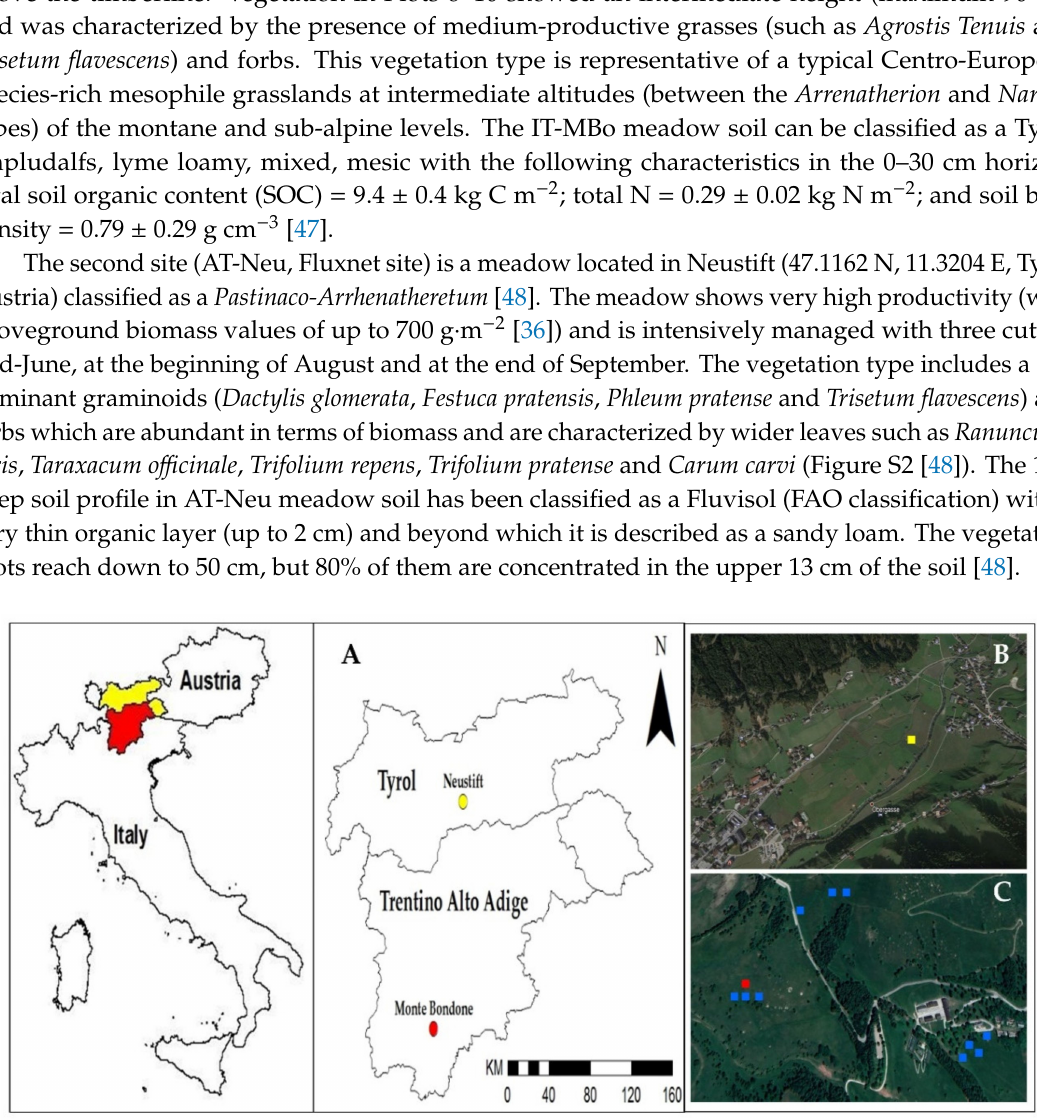
Figure 1. Location of the study sites ( A ); RGB Google Earth image of the AT-Neu site, where the yellow square represents the plot for temporal observations ( B ); and RGB Google Earth image of the IT-MBo site, where the red square represents the plot for temporal observations, while the blue squares represent the plots for spatial observations ( C